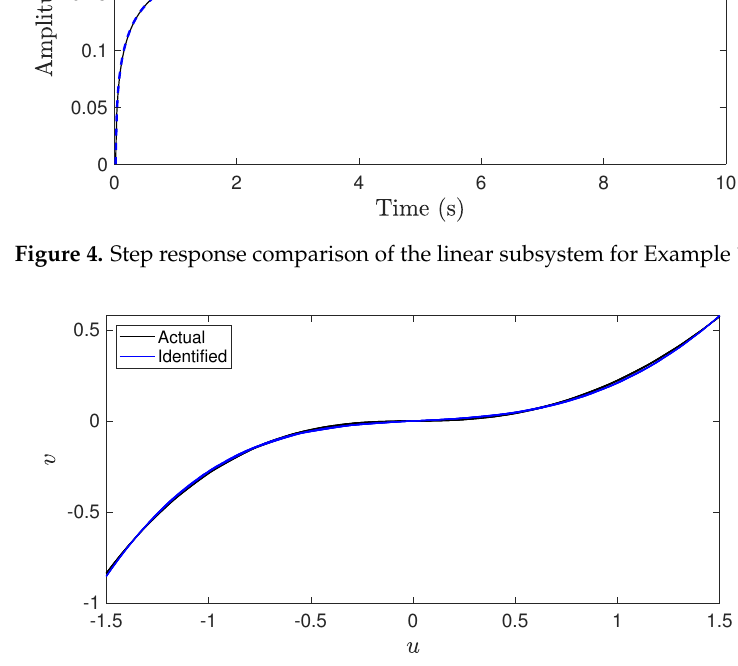
Figure 5. Comparison of the nonlinear static function for Example